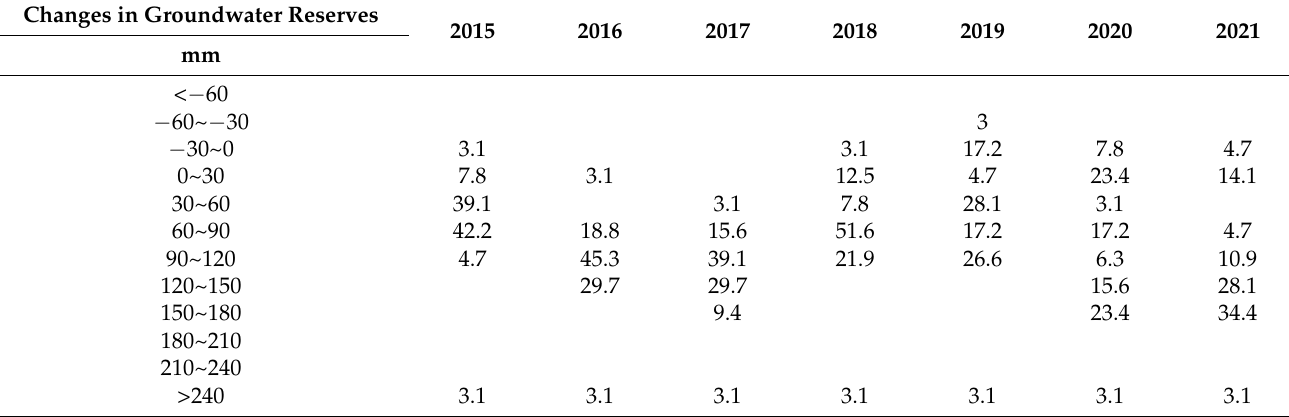
Table 2. Monitoring statistics of groundwater storage changes in the mainstream of Tarim River from 2015 to 2021 (unit: